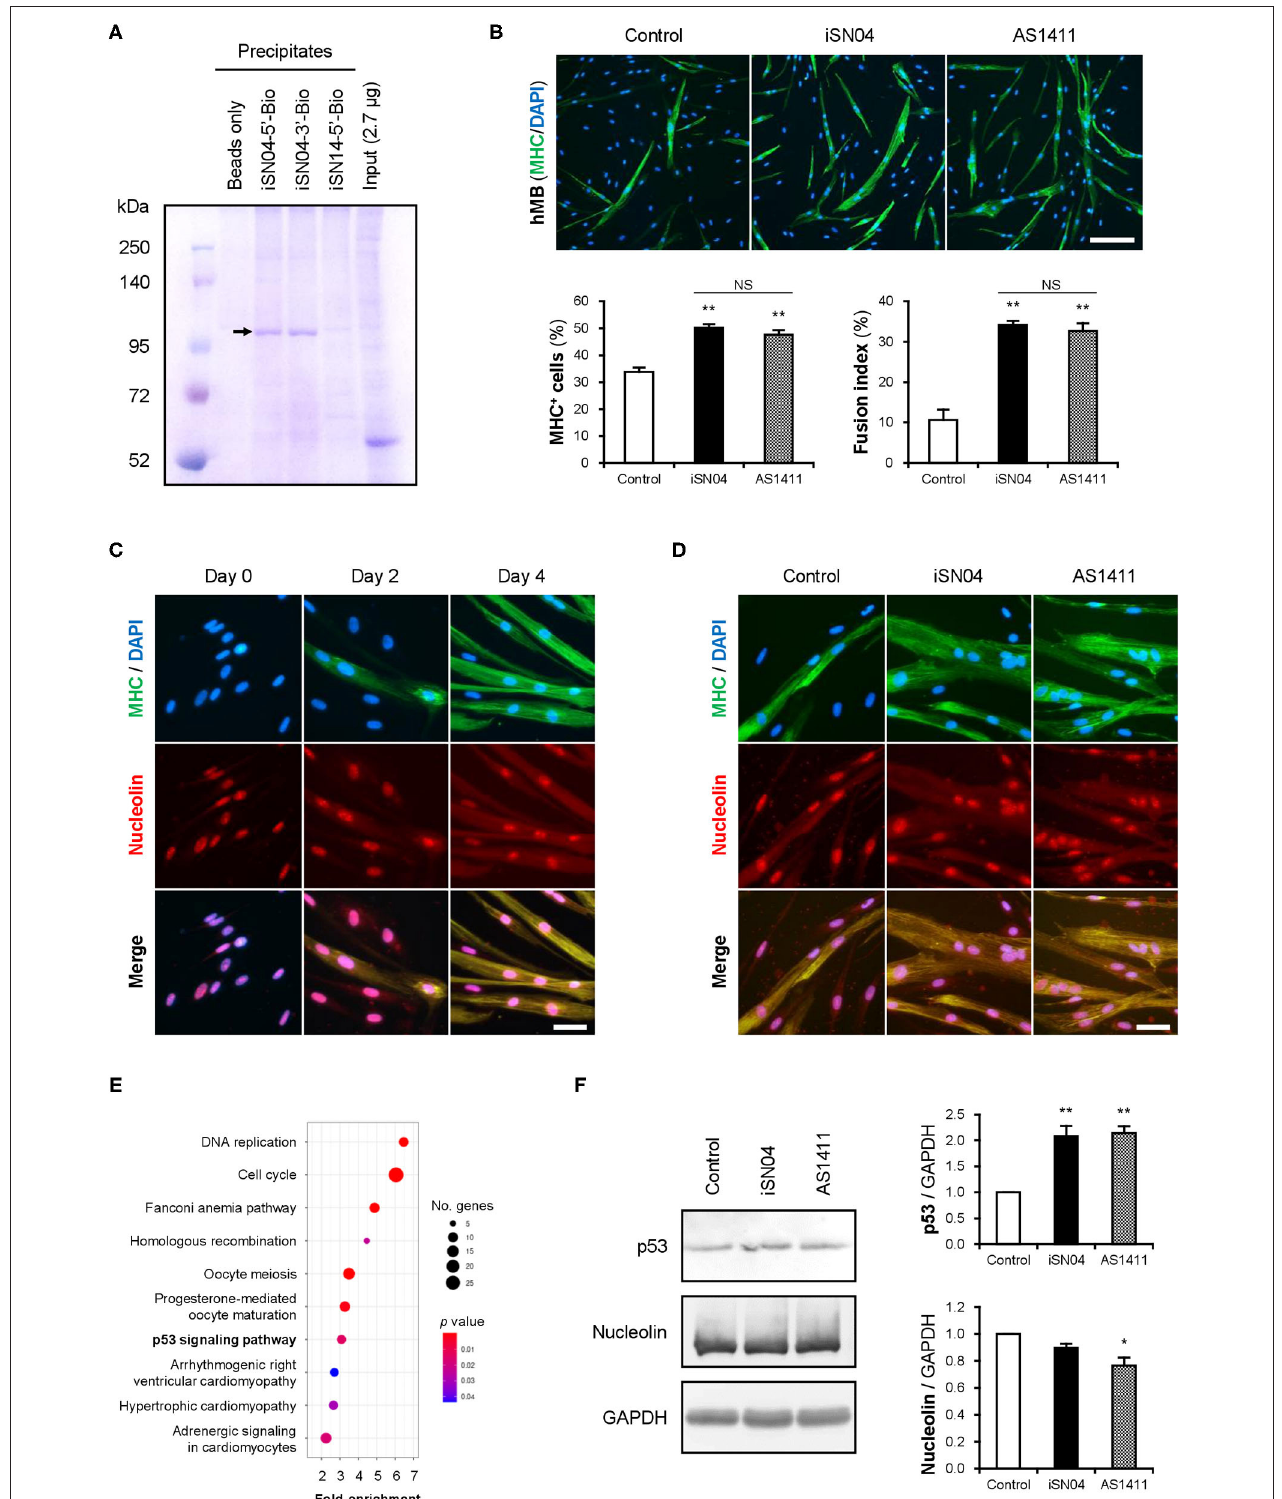
FIGURE 4 | iSN04 targets nucleolin and improves p53 protein level. (A) Representative image of CBB-stained SDS-PAGE gel of the ODN-precipitated proteins. The arrow indicates the bands subjected to mass spectrometry. (B) Representative immunofluorescent images of the hMBs treated with 10 µ M of iSN04 or AS1411 in DM